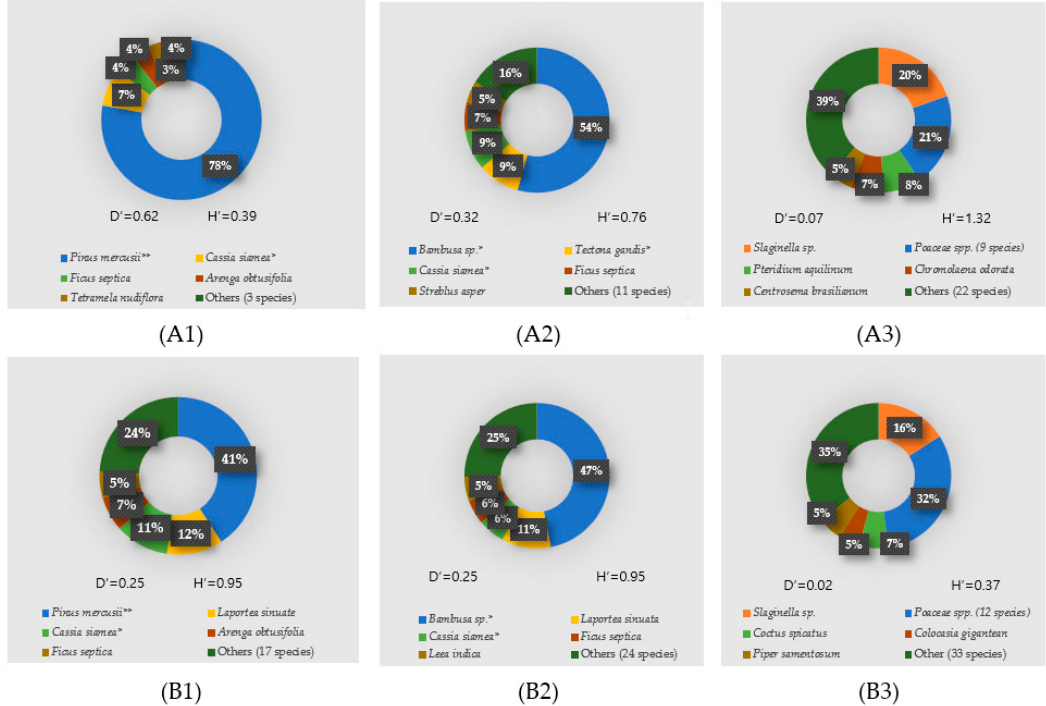
Figure 2. Species domination reflected by species composition (important value), dominance index, and diversity index (( A ) = Watujali; 1 = tree, 2 = sapling, 3 = seedling/herb; ( B ) = Silengkong; 1 = tree, 2 = sapling, 3 = seedling/herb).